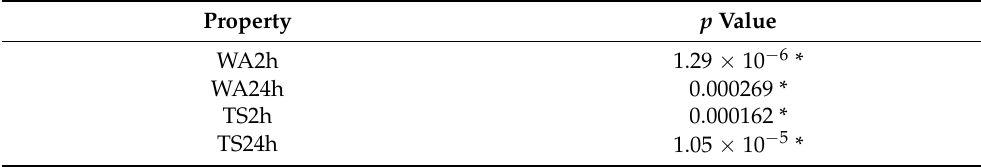
Table 5. p value of ANOVA for WA and TS at 2 and 24 h of submersion of the panels.